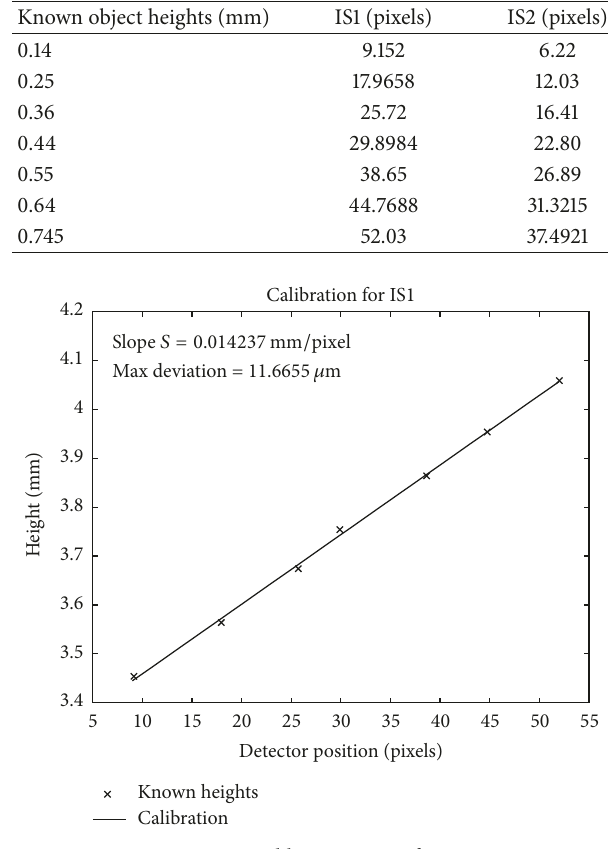
Figure 13: Calibration curve for IS1.